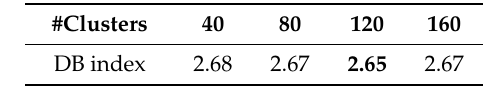
Table 2. Comparison of the DB index according to the number of